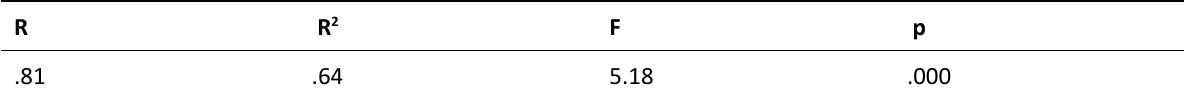
Table 3. Regression analysis of motor abilities and criteria variables sprint 100 m R R 2 F p